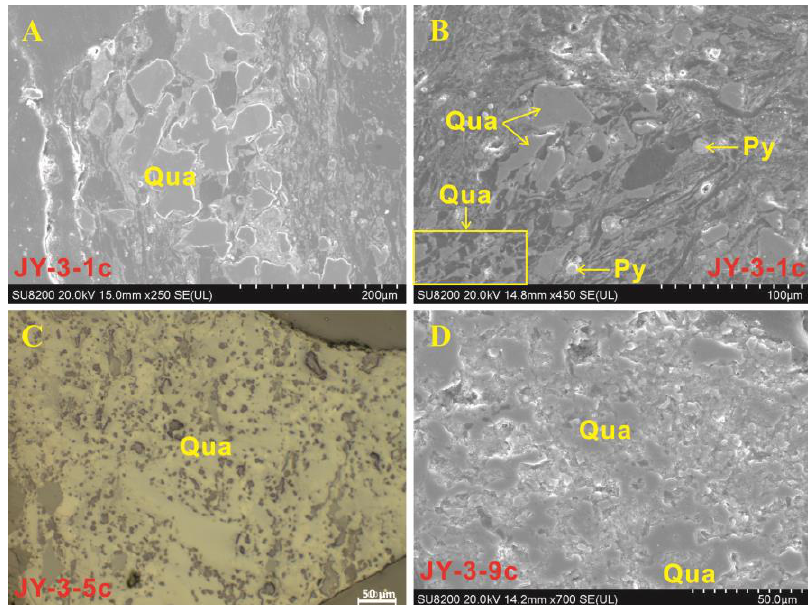
Figure 6. SEM secondary electronic and reflected light optical microscope images of Quartz (Qua) in the JY-3 Coal. ( A , B ), detrital quartz and cell-filling quartz; ( C , D ), authigenic quartz.